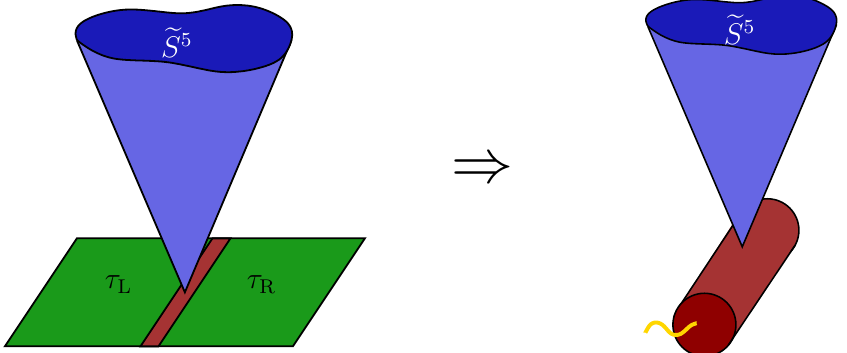
Figure 1. A schematic illustration of the Janus (left) and J-fold (right) configurations in N = 4 SYM realized by D3-branes at the tip of a cone over a deformation of S 5